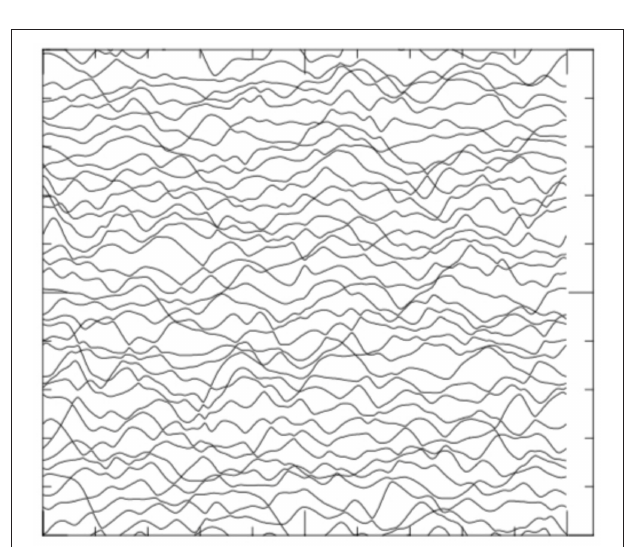
FIGURE 3 | In nuclei the level density increases with the excitation energy quite fast, practically exponentially at energies of the order of the